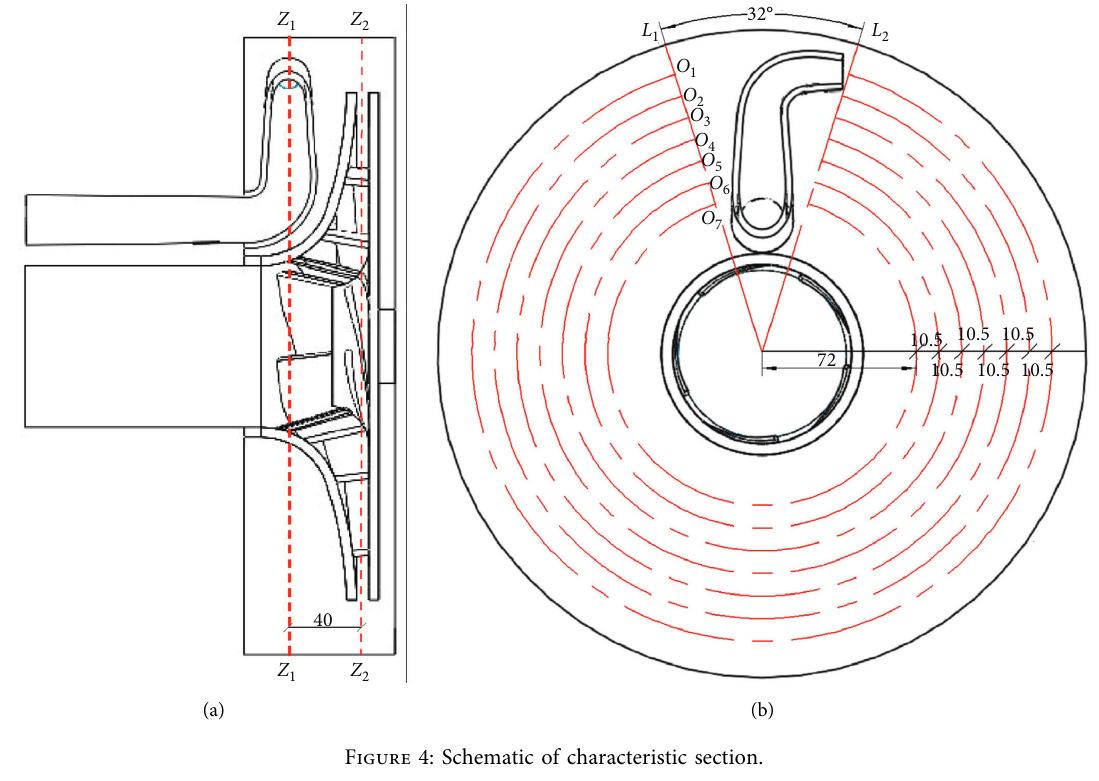
Figure 4: Schematic of characteristic